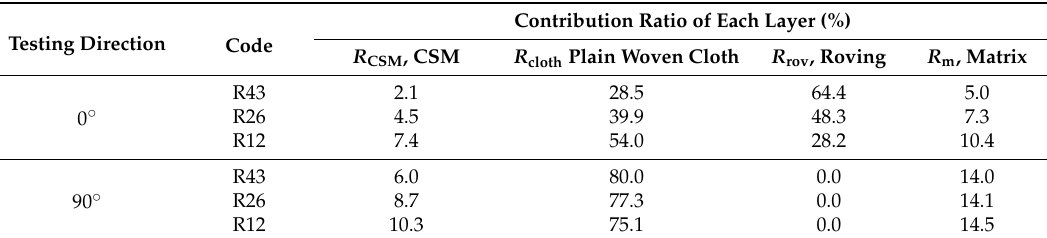
Table 5. Contribution ratios of each layer based on the rule of mixtures.